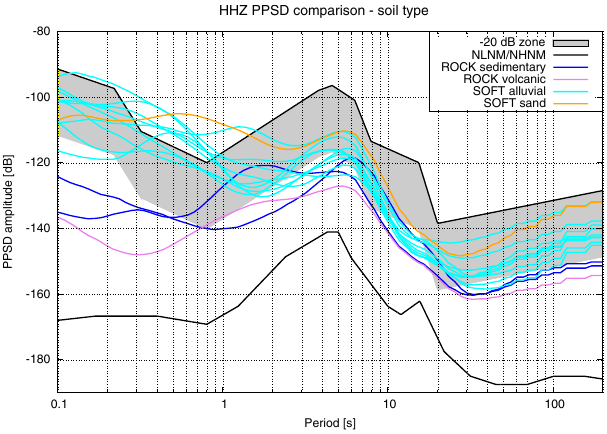
Figure 5. Comparison of the mean vertical PPSD of all the AASN stations managed by INGV as function of the soil type using the data of the first 40–60 days after installation. Gray lines repre- sent the Peterson NHNM and NLNM, in gray the − 20dB area be- low the NHNM. All rock sites are below or approach the NHNM − 20dB level and satisfy reasonably well the experiment specifi- cation both at longer periods and at higher frequencies. Most soft soil site (mainly Po plain and Adriatic coast) are below the NHNM − 10dB for long period but fail to meet the NHNM model for higher frequencies mostly because of cultural noise typical of those areas. The worst soft soil sites are only a few dB below the NHNM model at long periods. Basically the same behavior is observed for the hor- izontal components that at longer periods are usually at least 15dB above the vertical